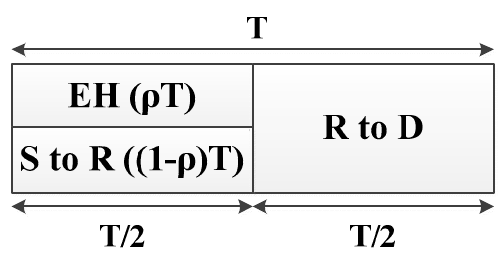
Figure 2. Power splitting (PS) protocol.